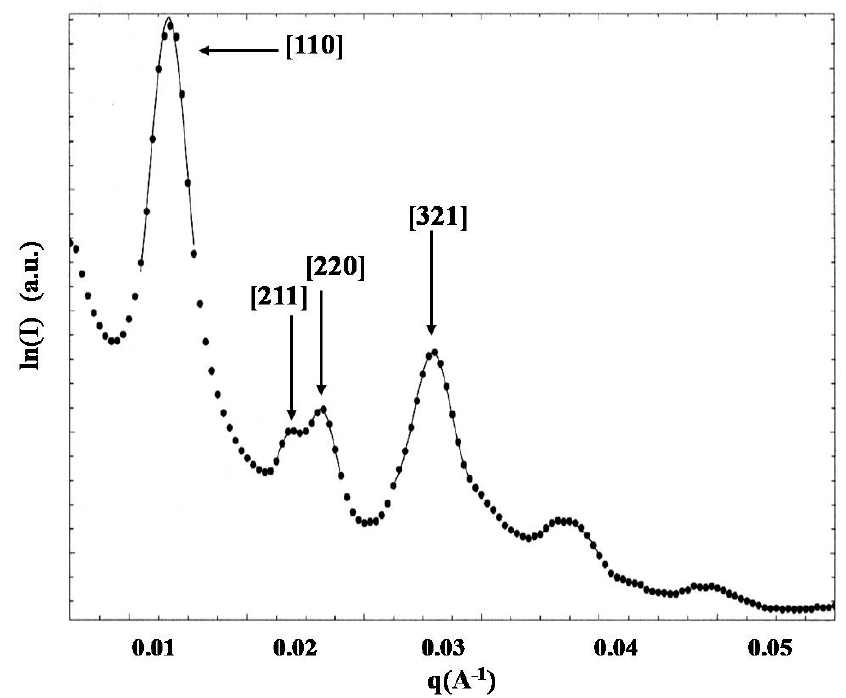
Figure 4. Bright-field TEM image, and a “magnified area” for enhancing details, exhibiting approximately a [100] projection. The insert at the upper left of the TEM image is the corresponding FFT. White areas correspond to PS domains, grey areas to 3,4-PI blocks and the black areas to the PB segments after staining with OsO 4 for approximately 30 min.